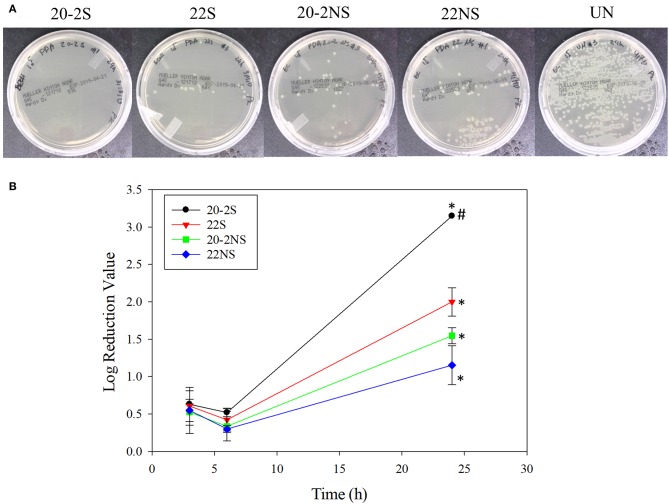
Photograph of the test plates for E. coli colonies exposed to PDA-coated meshes and the uncoated mesh control after 24 h (A). Log reduction values for E. coli colonies incubated with the PDA-coated meshes, which is normalized by the number of colonies formed by the bacteria exposed to the uncoated mesh (B). Data are shown as mean ± standard deviation of three independent samples. *p < 0.05 when compared to other PDA coated samples. #completely killed bacteria.